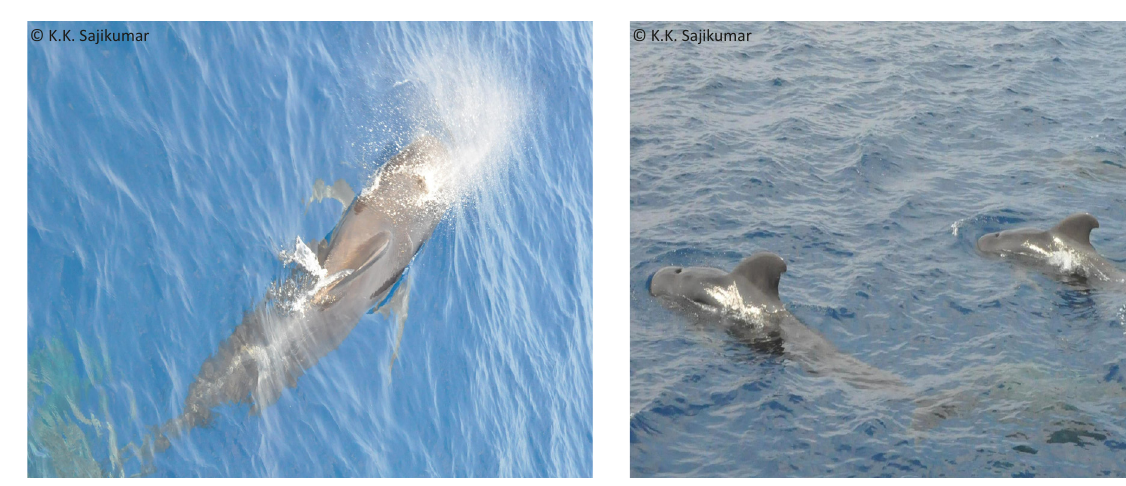
6. Blow of pilot whale show a bushy spout.